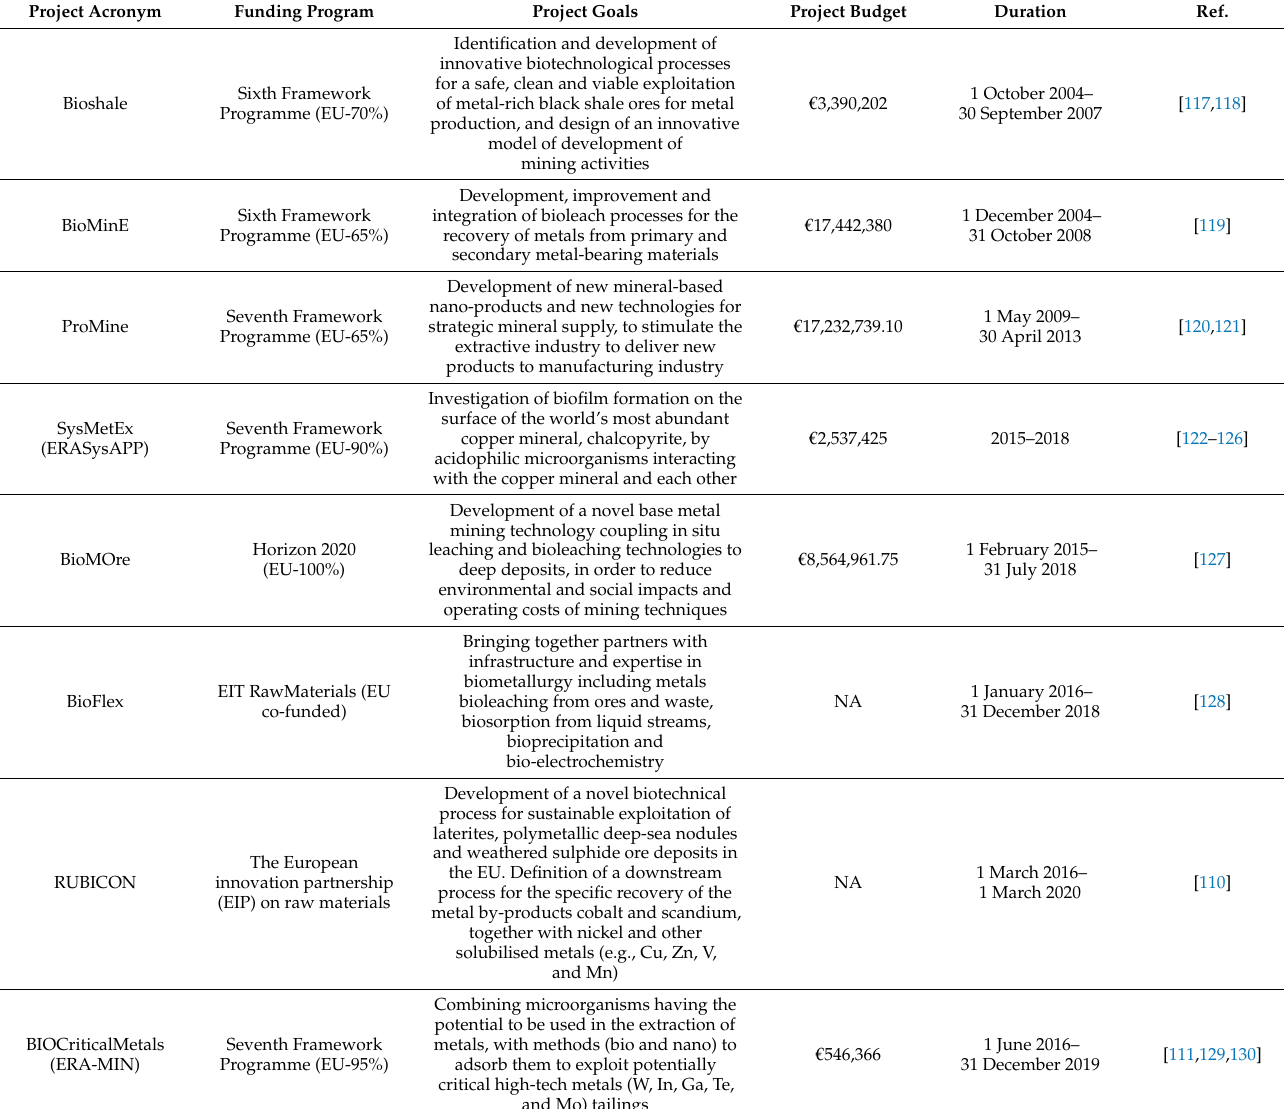
Table 2. Overview of active and completed bioleaching projects founded by the EU in the last two decades. For each project, the funding program, project goals, budget and duration are